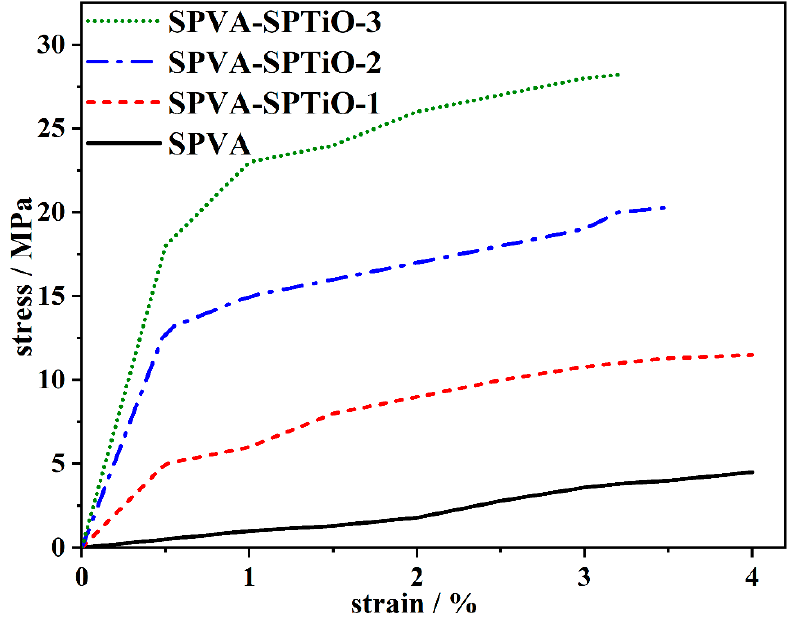
Figure 8. The stress vs. strain curves of the prepared membranes.